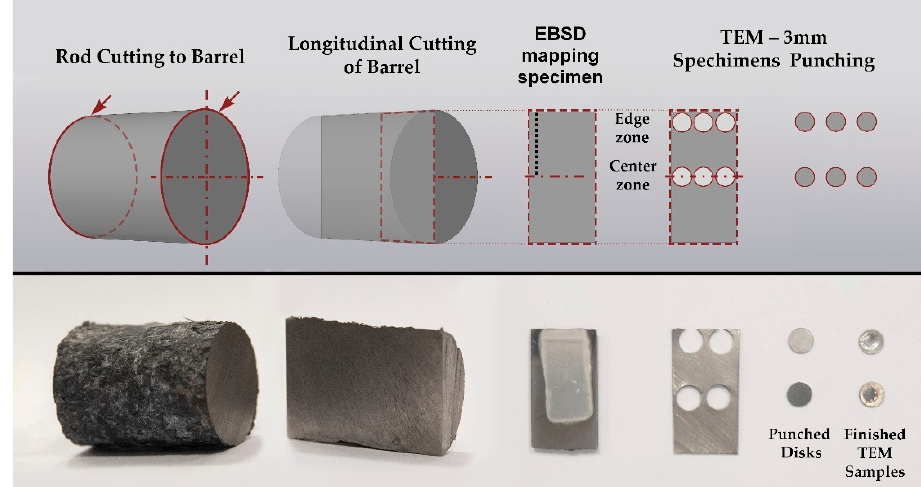
Figure 8. The sample cutting scheme for various characterization methods.